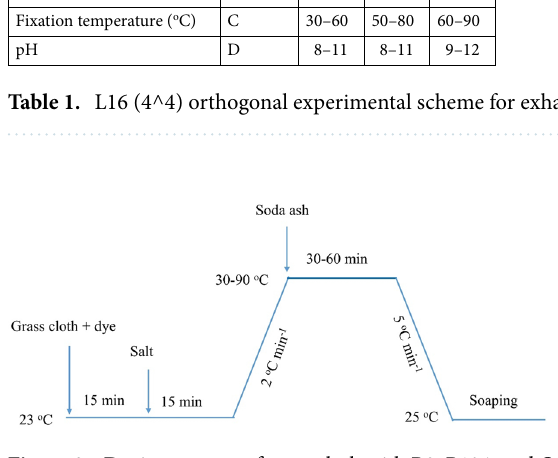
Figure 2. Dyeing process of grass cloth with R2, B194, and O5 in